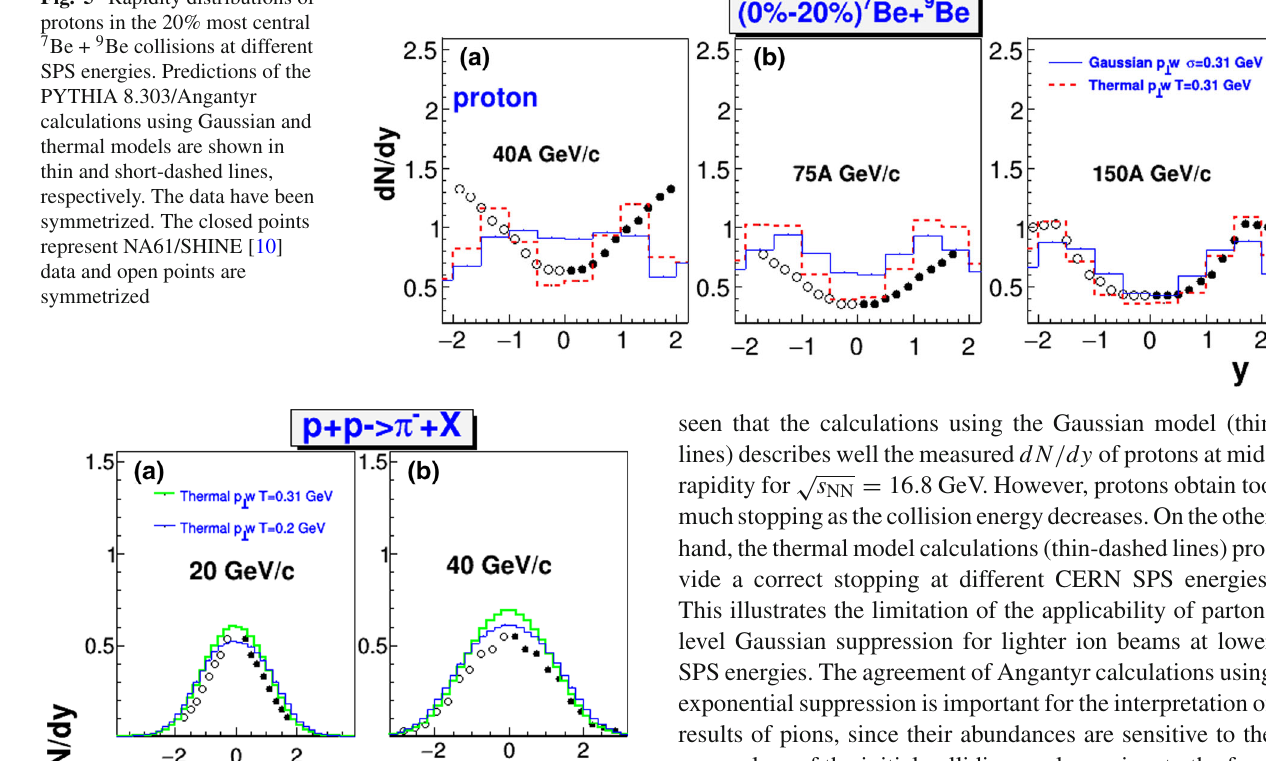
Fig. 5 Rapidity distributions of protons in the 20% most central 7 Be + 9 Be collisions at different SPS energies. Predictions of the PYTHIA 8.303/Angantyr calculations using Gaussian and thermal models are shown in thin and short-dashed lines, respectively. The data have been symmetrized. The closed points represent NA61/SHINE [10] data and open points are symmetrized